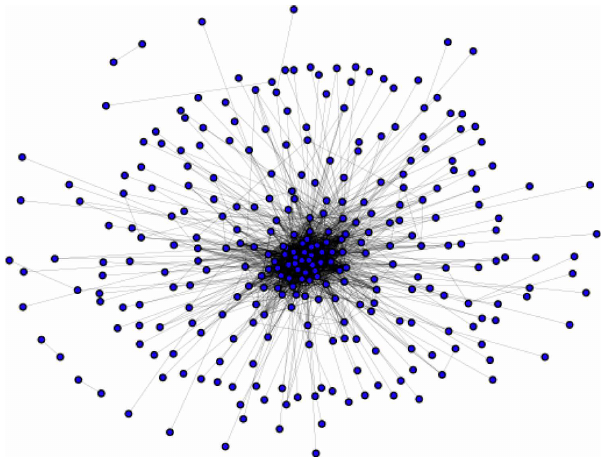
Figure 8: An illustration of the rides sub-network 𝐺 the structure that is implied by the aggregation of the rides between the 144-th and the 145-th hour of the